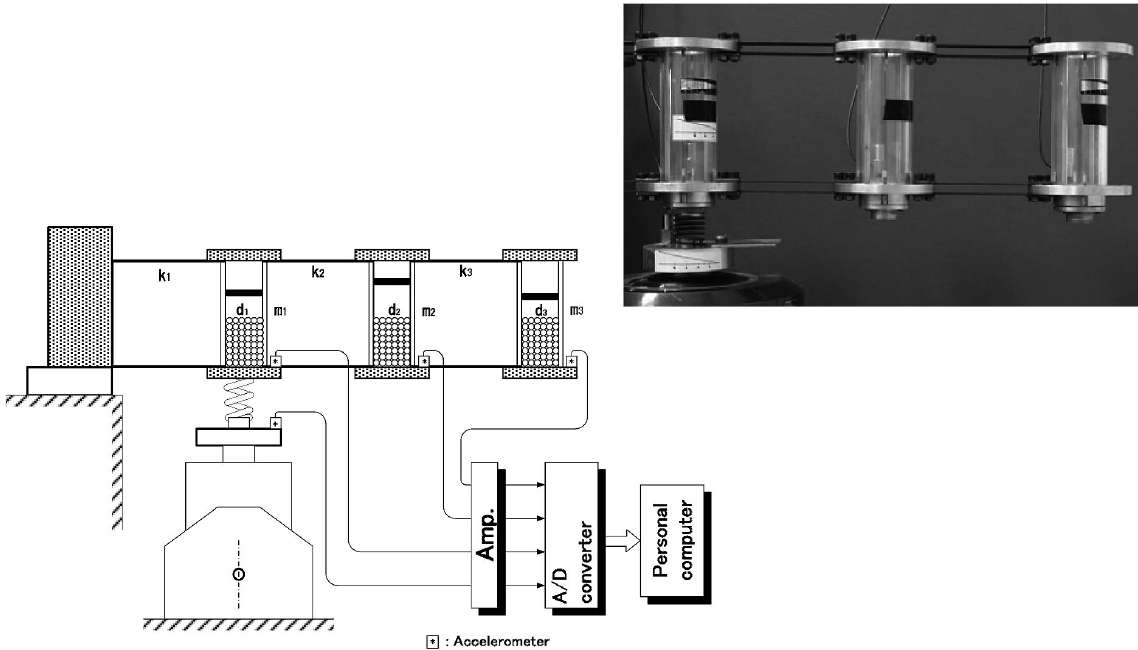
Fig. 7. Experimental setup for 3DOF